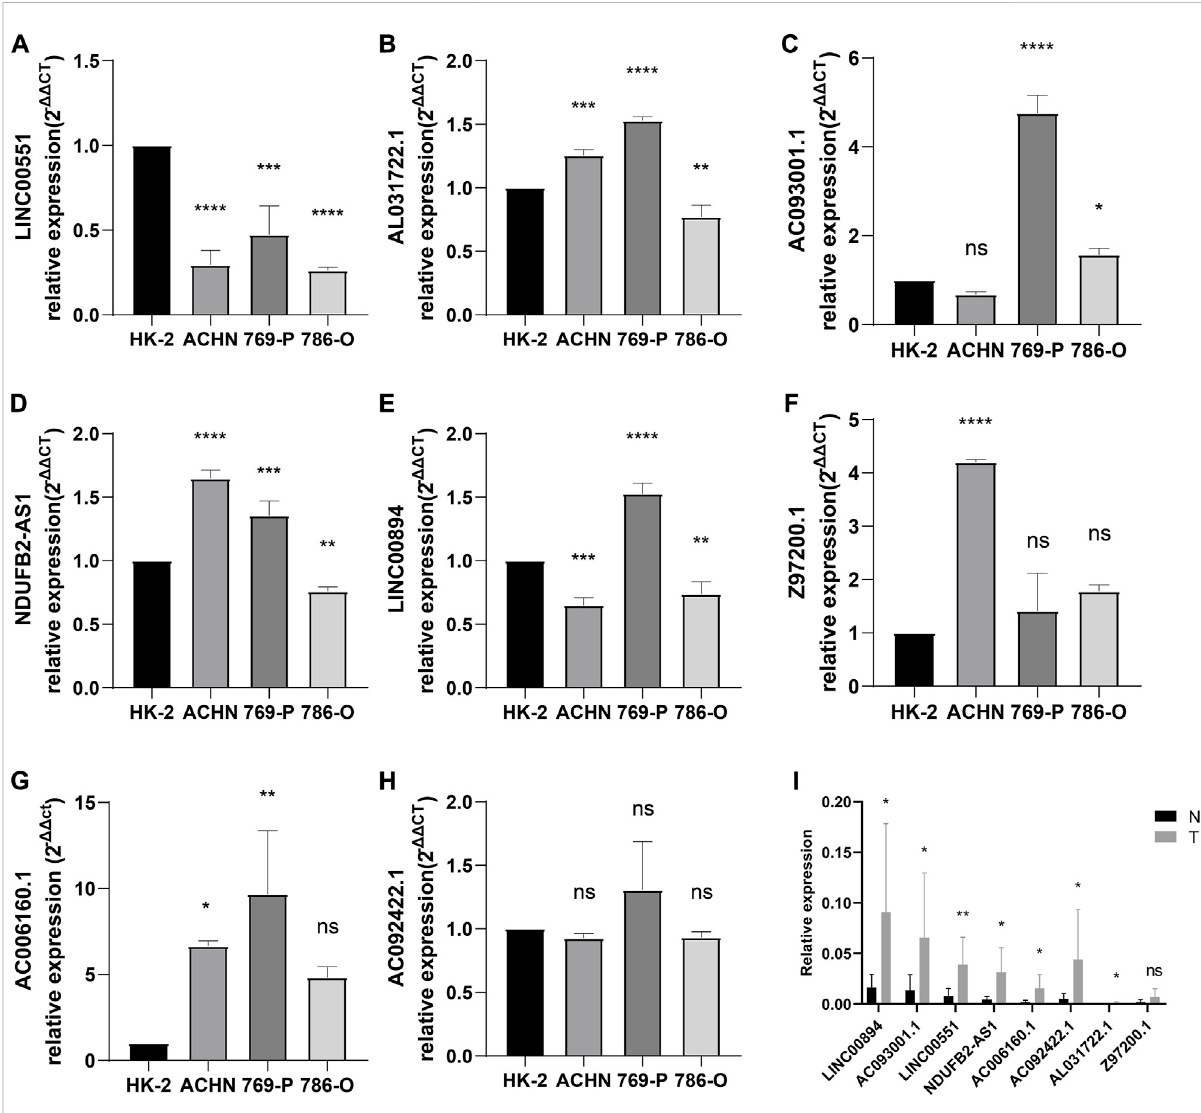
FIGURE 3 Veri fi cation of gene expression. (A) LINC00551, (B) AL031722.1, (C) AC093001.1, (D) NDUFB2-AS1, (E) LINC00894, (F) Z97200.1, (G) AC006160.1, and (H) AC092422.1 expression in normal and kidney cancer cell lines; (I) eight lncRNAs expression in normal kidney tissue and KIRC tissue. *p < 0.05; **p < 0.01; ***p < 0.001; ****p <